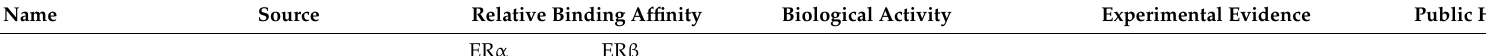
Table 2. Various phytoestrogens and their implications for cancer. Compilation of ten types of phytoestrogens and their sources, biological and experimental evidence from pre-clinical studies, and implications for cancer. Relative binding affinities were adapted from Kuiper et al. [25], unless otherwise noted, with E2 set as